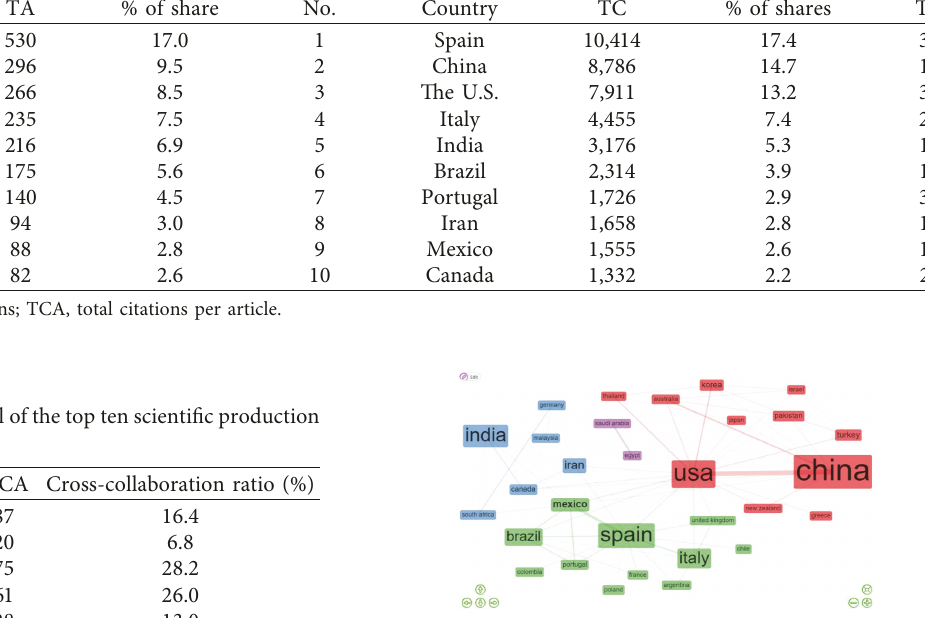
Figure 3: The research networks among the top 30 science-pro- ducing